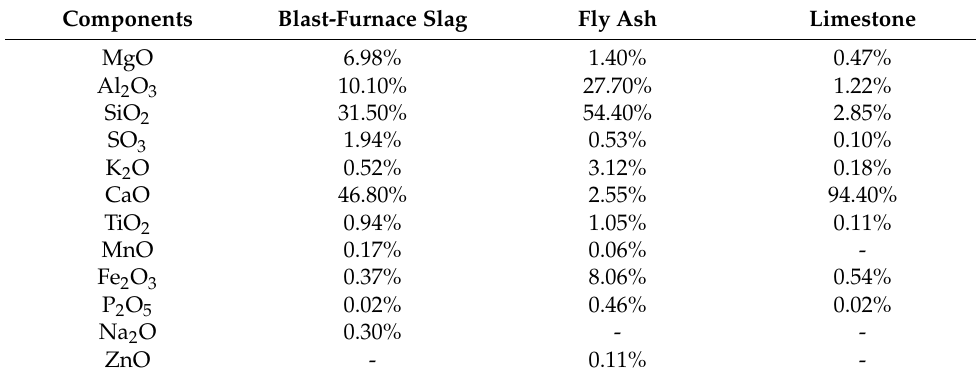
Table 2. Chemical components of limestone, fly ash, and blast-furnace